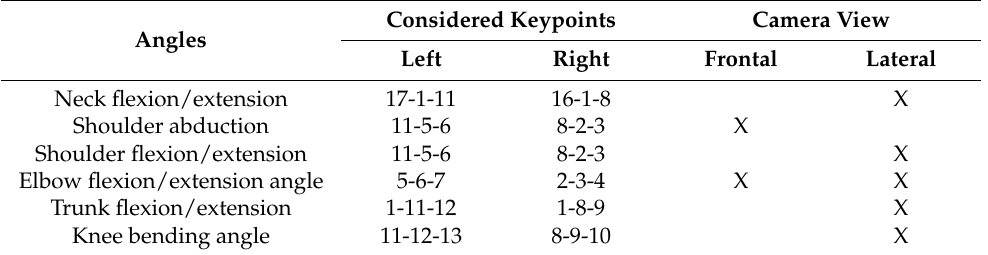
Table 1. Body key points and camera views considered in the computation of the angles.